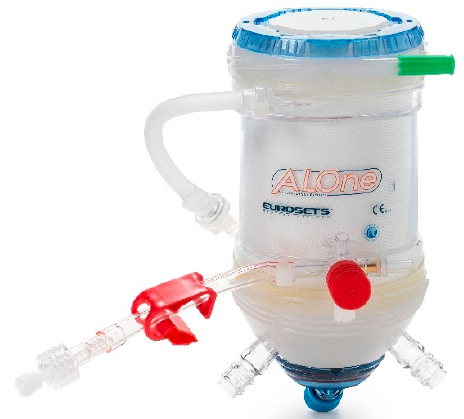
Figure 3. A.L.ONE AF PLUS Oxygenator.